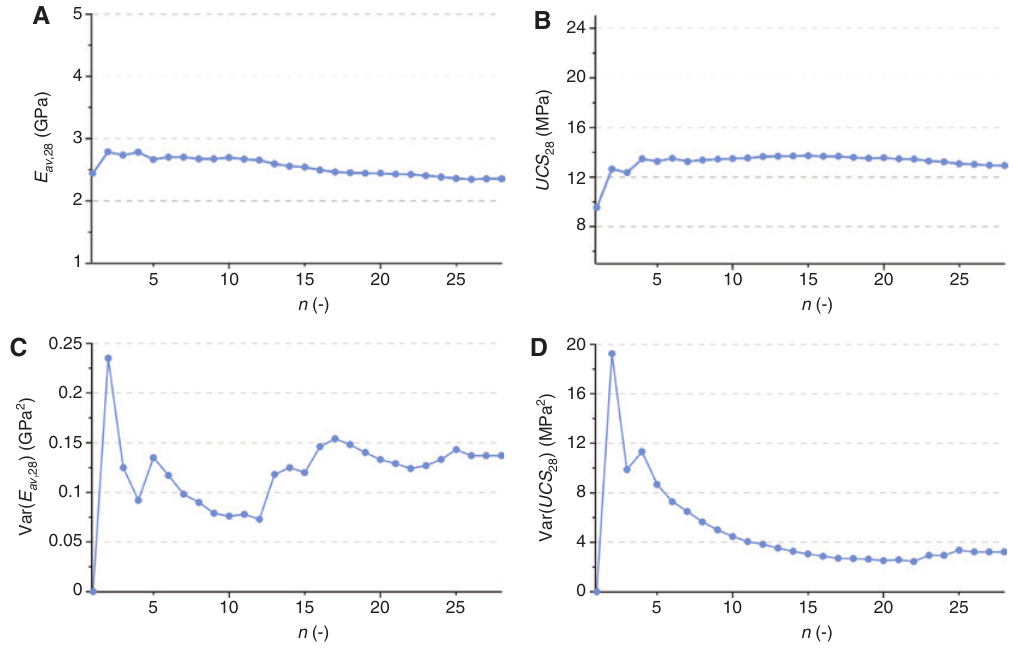
Figure 14: The results obtained for gypsum specimens of diameter D = 28 mm. (A) the mean value of Young modulus, (B) the mean value of UCS , (C) variance of Young modulus and (D) variance of UCS , as a function of the number of performed tests n .